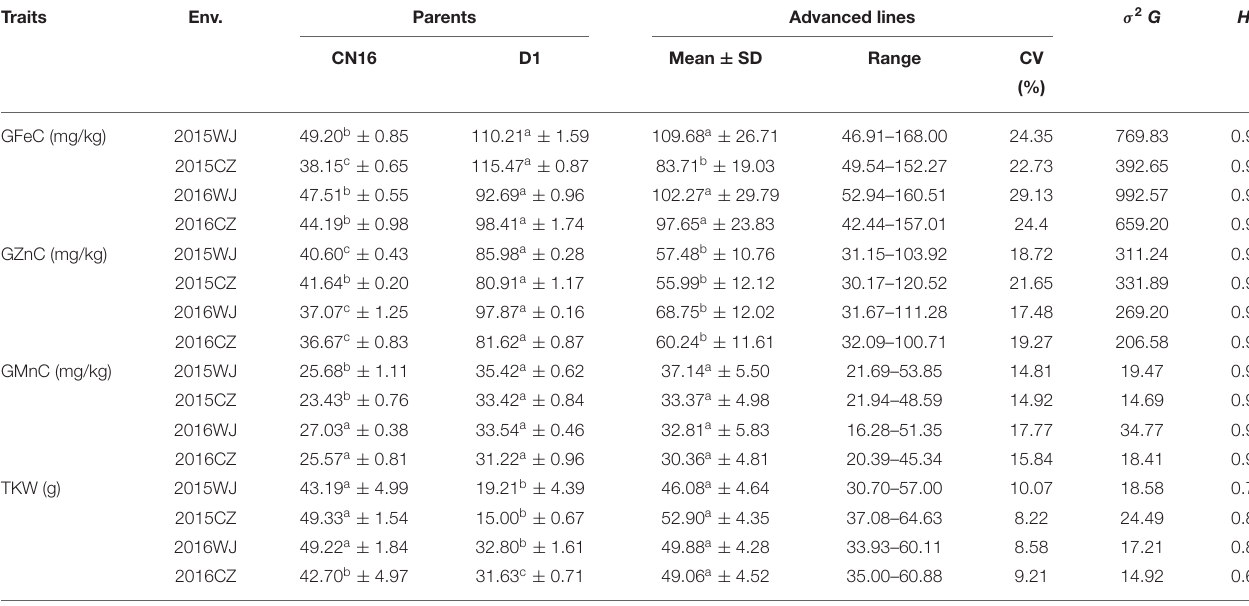
TABLE 1 | The variation for GFeC, GZnC, GMnC, and TKW in advanced lines under four environments. Traits